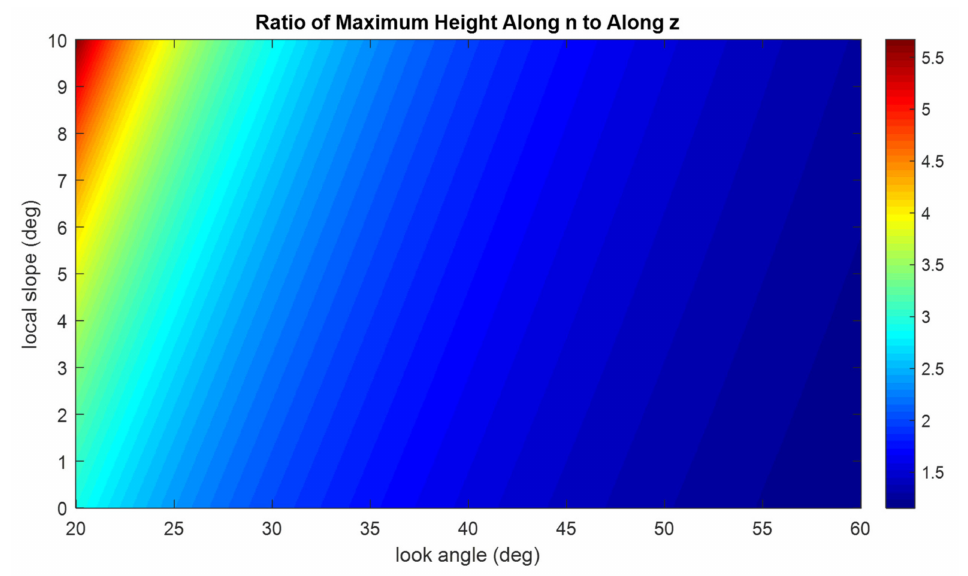
Figure 5. The ratio of h max n / h max z